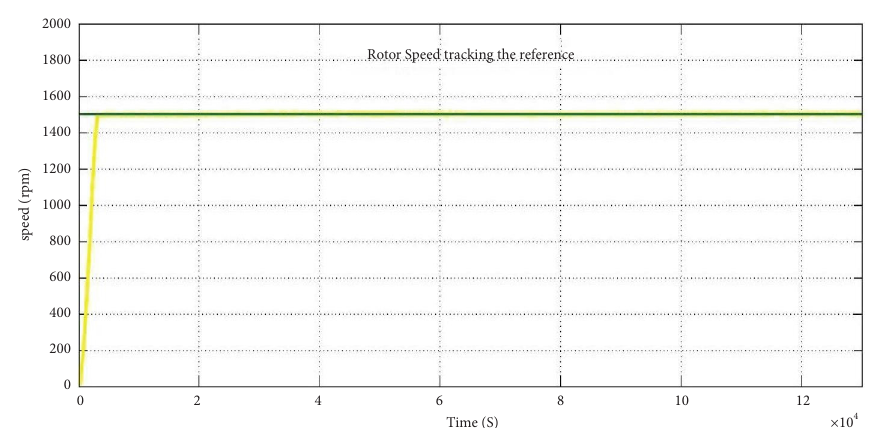
Figure 16: Rotor speed tracking waveform.